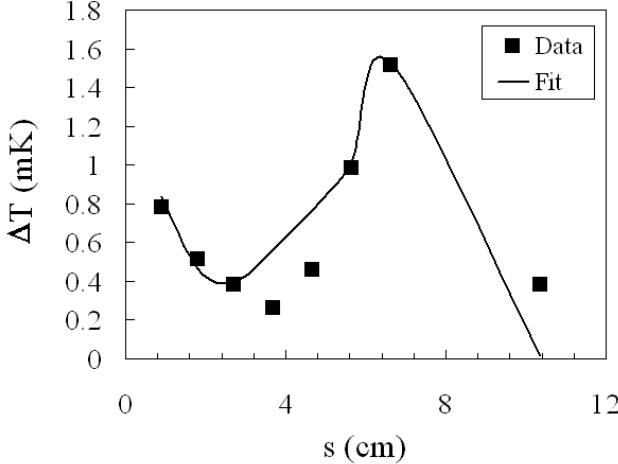
(cid:6) 16 mT p (cid:6) 10 cm 2 K = W , R (cid:6) T s